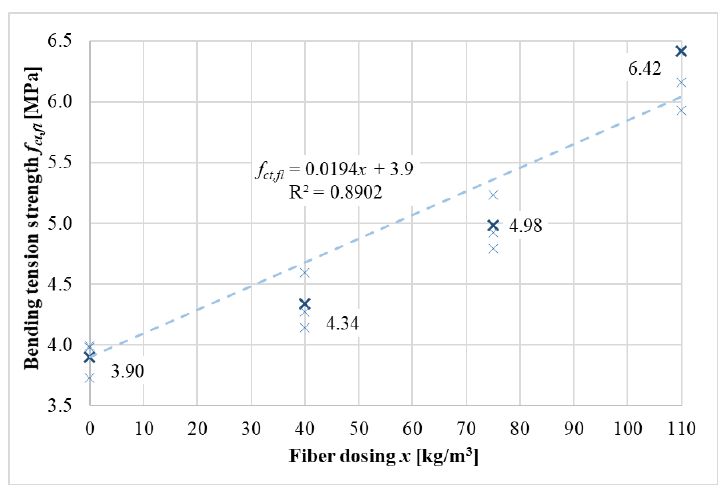
Figure 12. Regression analysis to determine the functional dependence of the bending tensile strength f ct,fl on fiber dosage x .